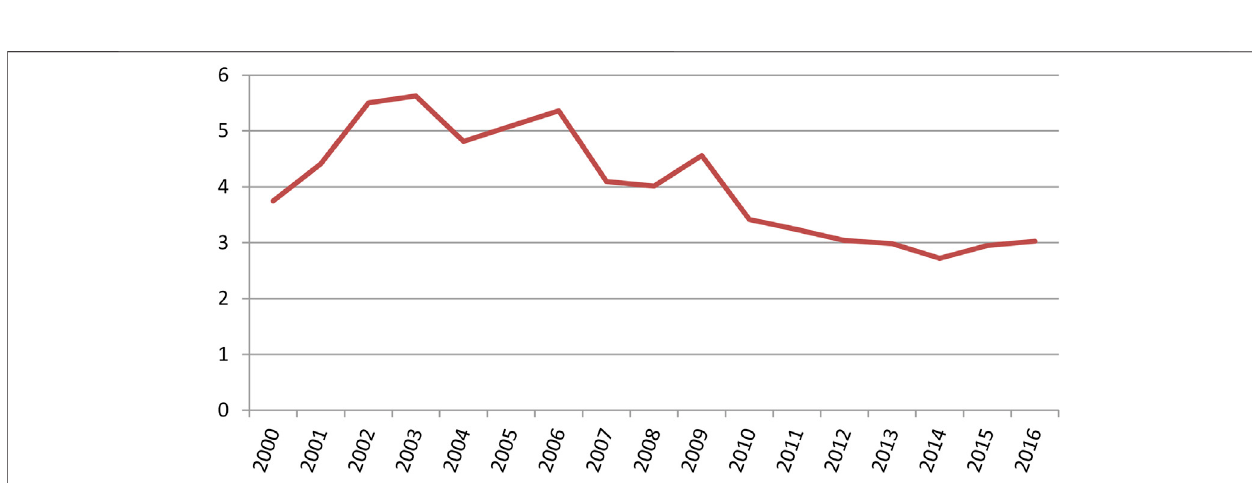
FIGURE 2 | Net ODA received (% of GNI) in sub-Saharan Africa. Source: World Development Indicator (2016).